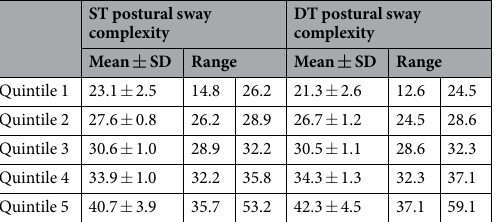
Table 3. Postural sway complexity quintiles. Note : ST = single task standing; DT = dual task standing.